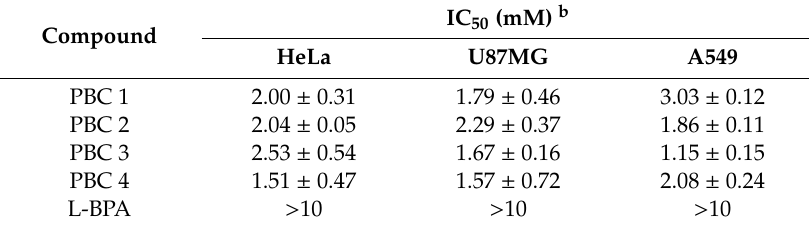
Table 1 . Cytotoxicity of PBCs 1–4 toward HeLa, U87MG, and A549 cells a . Table 1. Cytotoxicity of PBCs 1–4 toward HeLa, U87MG, and A549 cells a .